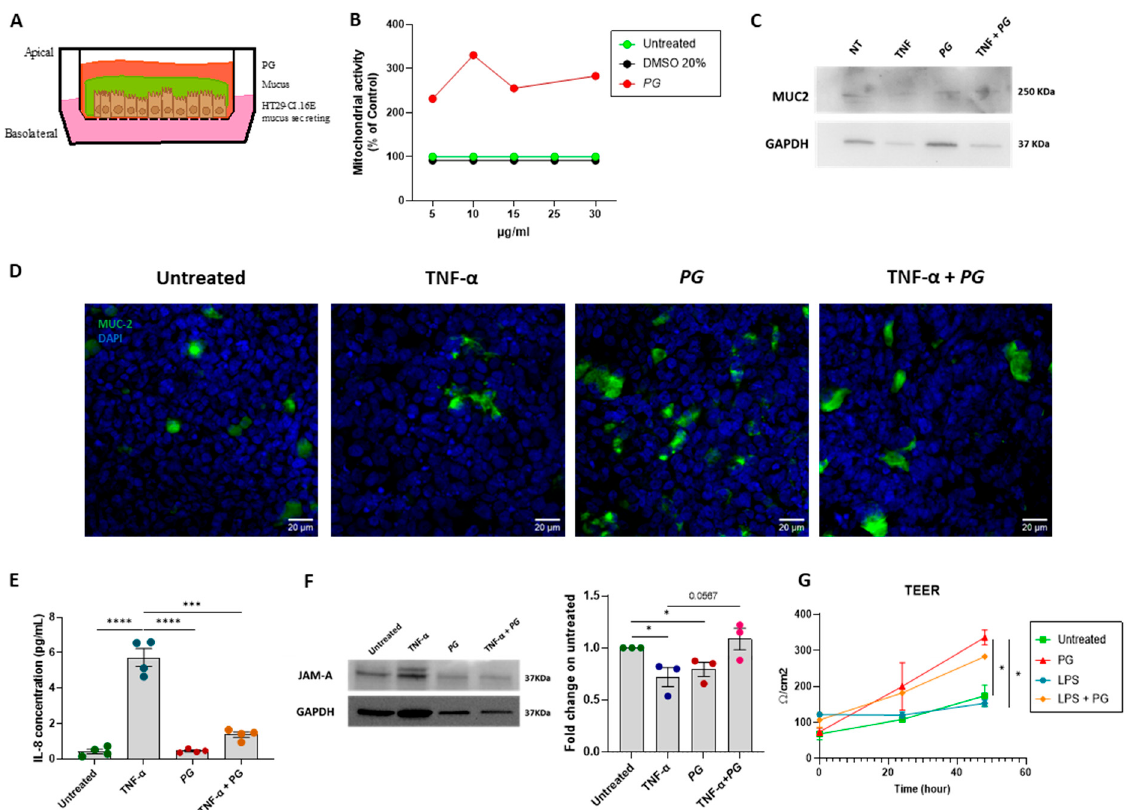
Figure 3. PG enhanced the epithelial barrier integrity in vitro, modulating the mucus layer and junctional adhesion protein production. ( A ) Schematic representation of in vitro experimental plan, in which the mucus secreting cells, HT29C1.16E, after apical and basolateral polarization on transwell supports, were stimulated with PG . ( B ) MTT assay was performed on HT29C1.16E cells after stimulation with PG at different concentrations (5, 10, 15, 25, 30 μ g/mL) for 48 h. HT29C1.16E untreated or stimulated with 20% DMSO was used as the control. ( C ) Representative Western blot of MUC2 and GAPDH as the control in HT29C1.16E untreated and treated for 48 h with TNF- α , PG , or TNF- α + PG . ( D ) Representative immunofluorescence of MUC-2 (green) in HT29C1.16E treated for 48h ± TNF- α , PG , or TNF- α + PG . DAPI = nuclei in blue. Scale bar = 20 μ m. ( E ) IL-8 ( PG /mL) levels in Caco-2 cells treated for 48h ± TNF- α , PG , or TNF- α + PG . n = 4/group. ( F ) Representative Western blot of JAM-A and GAPDH as housekeeping protein in Caco-2 cells treated for 48h ± TNF- α , PG or TNF- α + PG . JAM-A quantification relative to GAPDH was expressed as fold change in the untreated group. ( G ) Transepithelial electrical resistance (TEER)( Ώ /cm 2 ) was performed on Caco-2 cells treated ± PG or PG + LPS 24 and 48 h after stimulation. Data are presented as mean ± SEM. Unpaired t -test. * p < 0.05, p < 0.01, *** p < 0.001, **** p <0.0001 n = 3/group.